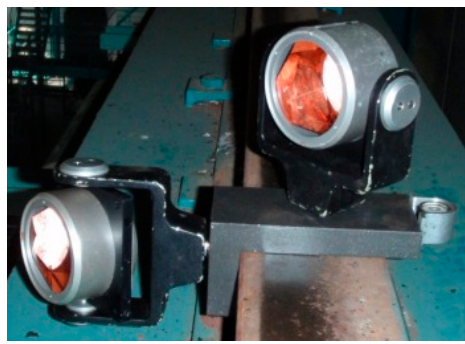
Figure 2. A special platform with two precise prisms.